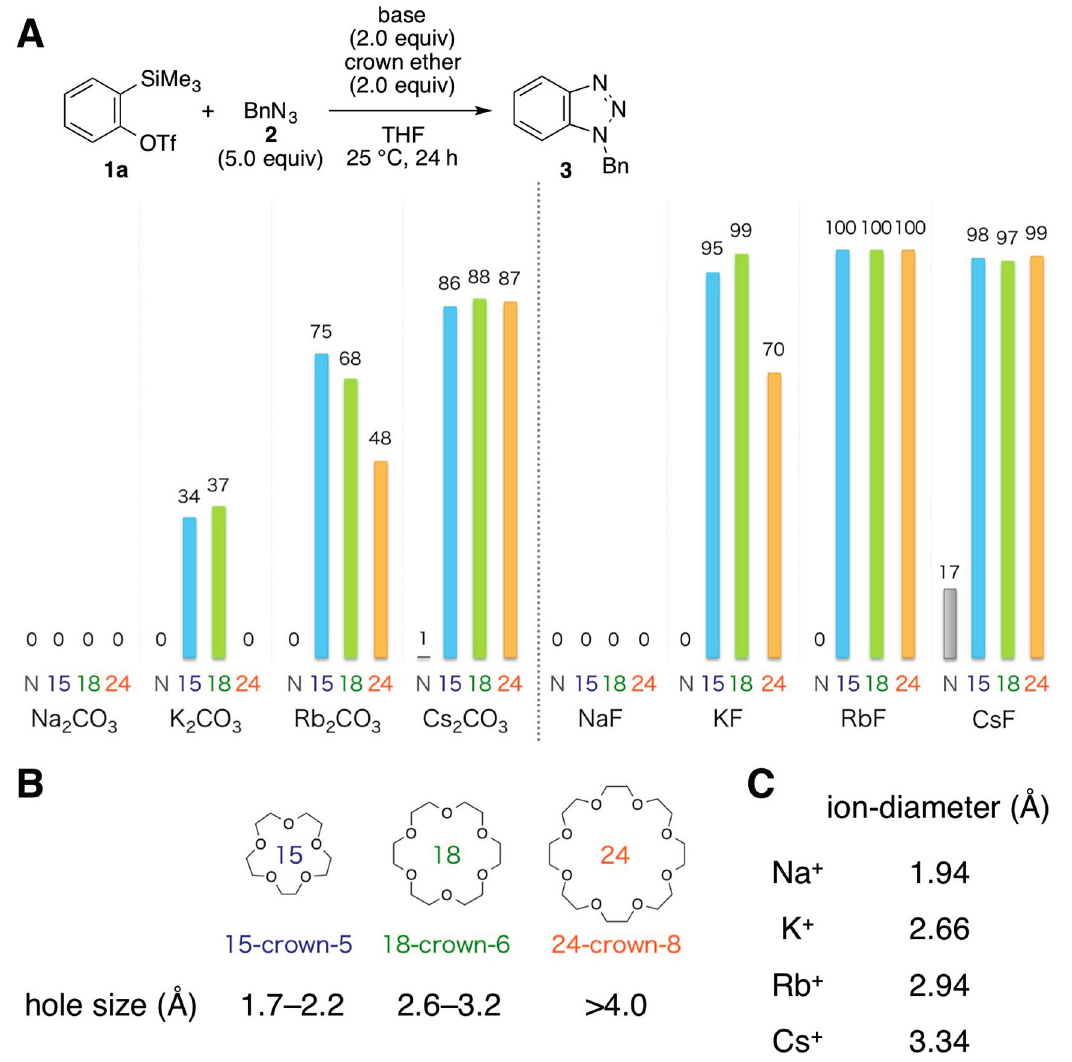
Figure 1. Generation of benzyne from 1a using various alkali metal carbonates or fluorides and crown ethers. ( A ) Efficiency of the reactions between 1a and 2 using various bases in combination with different crown ethers (N: without crown ethers; 15: with 15-crown-5; 18: with 18-crown-6; 24: with 24-crown-8). Yields determined by 1 H-NMR analyses; ( B ) Hole size of crown ethers; ( C ) Diameter of alkali metal